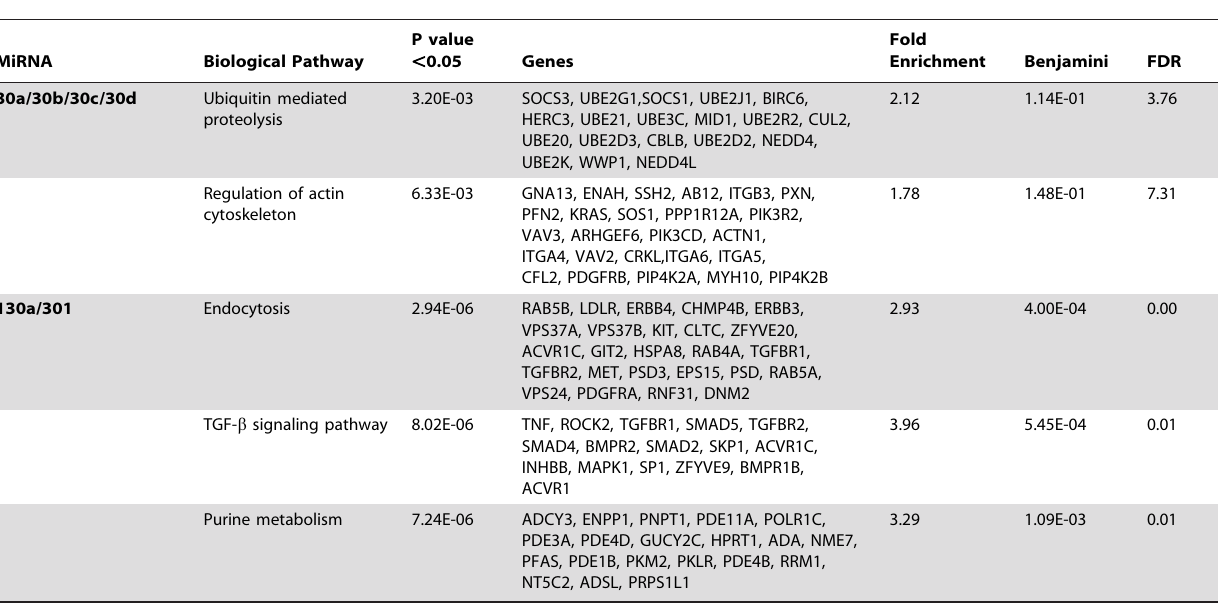
Table 1. Biological pathways targeted by miRNAs differentially expressed in HCV infection and following IFN- a treatment.